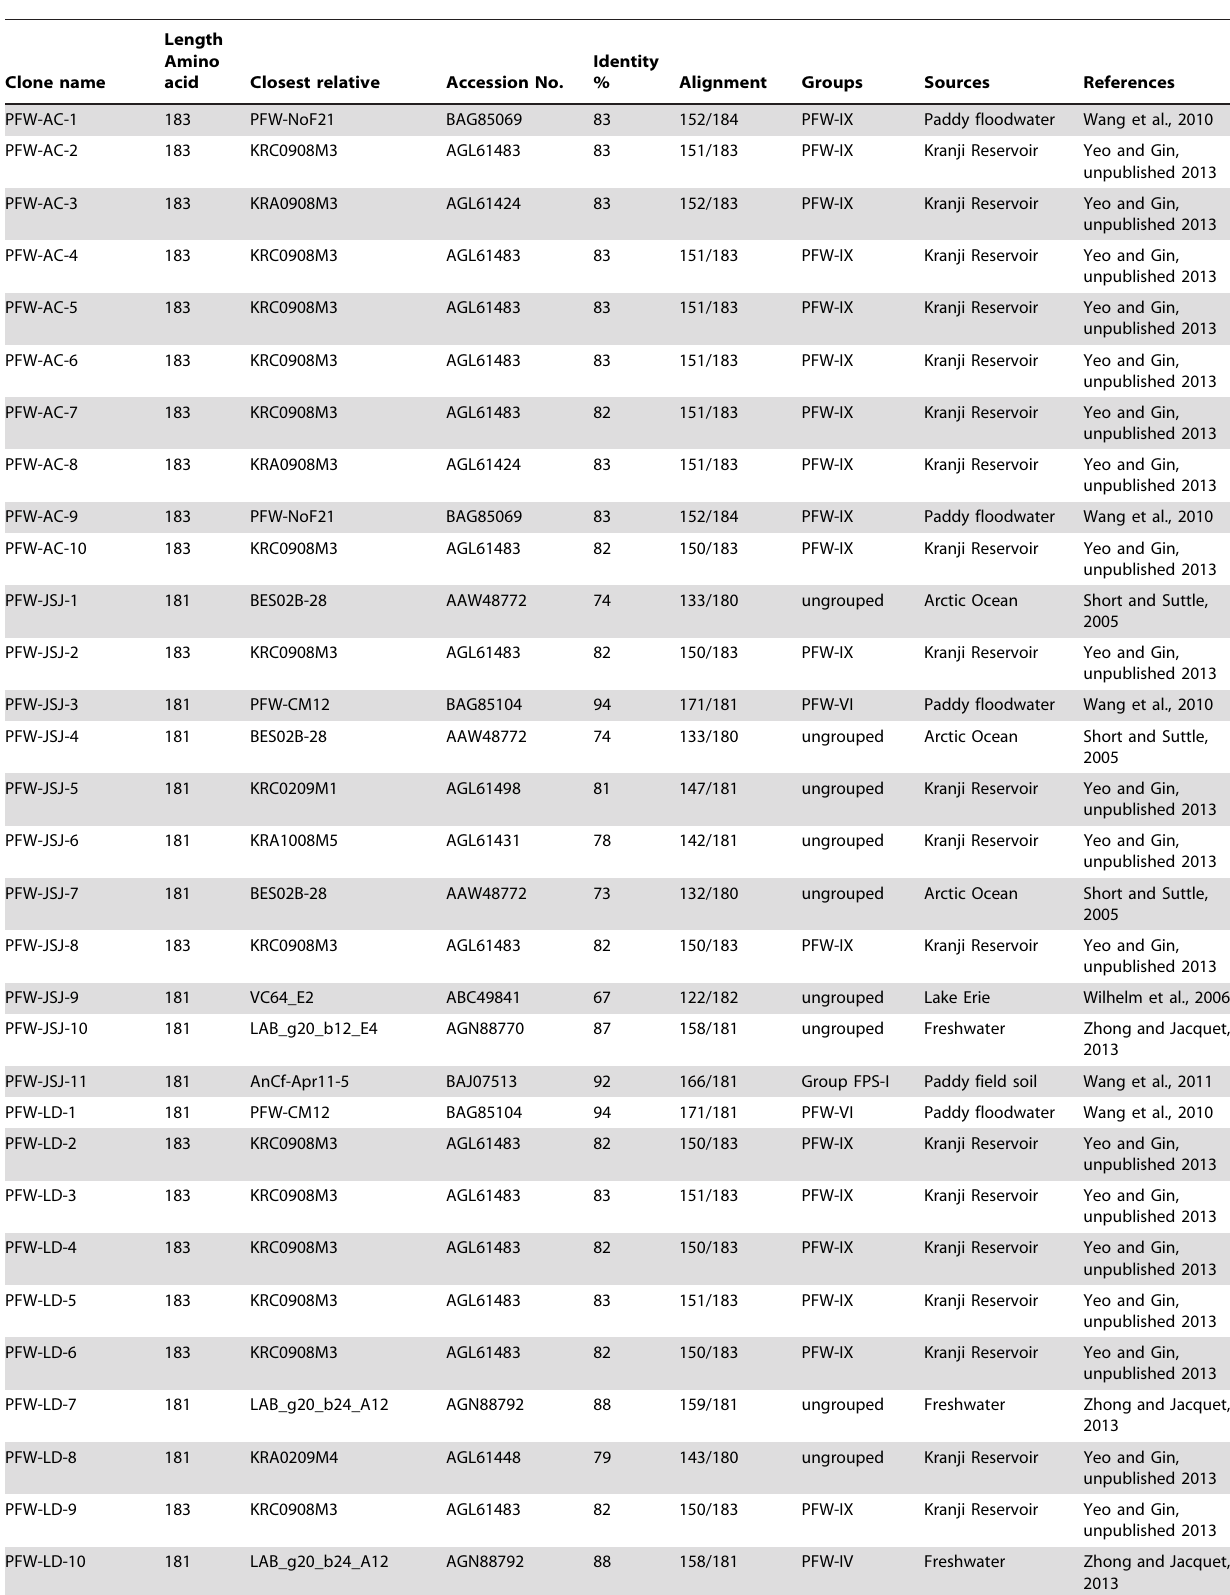
Table 1. Closest relatives of sequenced g20 clones from different paddy floodwaters at the amino acid